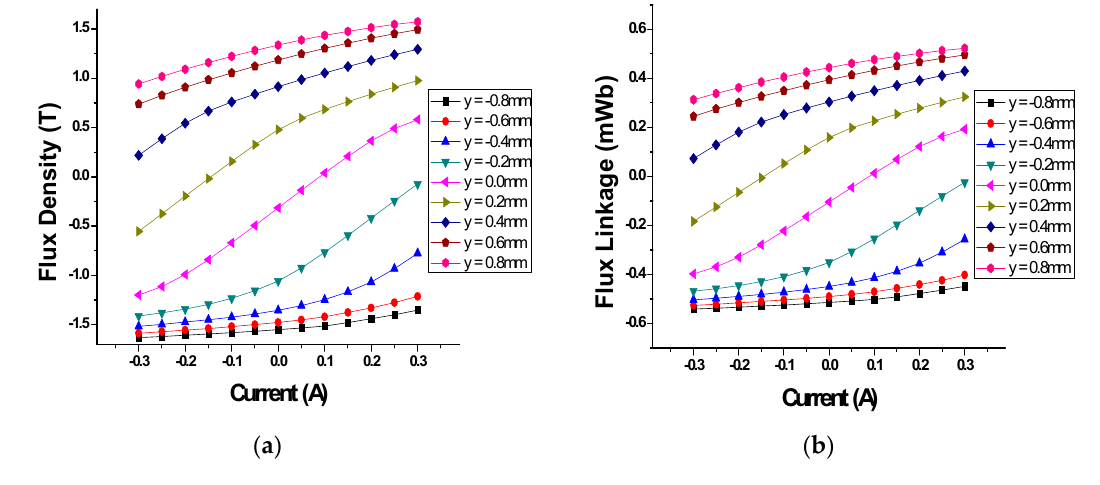
Figure 3. ( a ) Flux density, ( b ) flux linkage.